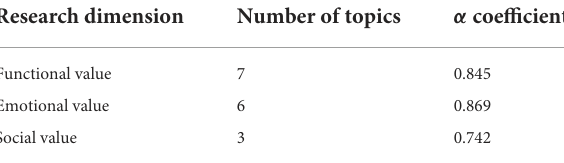
TABLE 3 Reliability of the